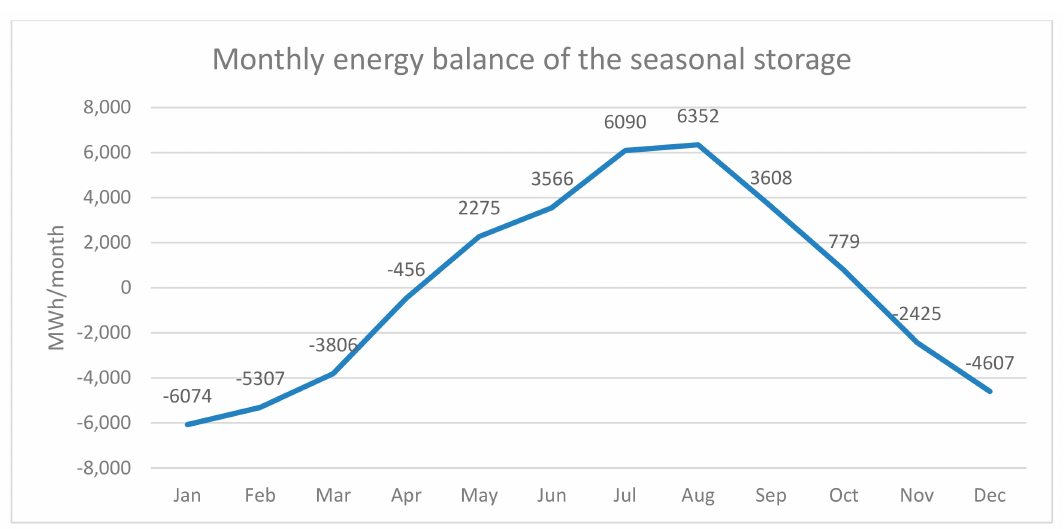
Figure 7. Monthly energy balance of the geothermal storage: negative values: energy extraction from the storage; positive values: feed-in to the storage.